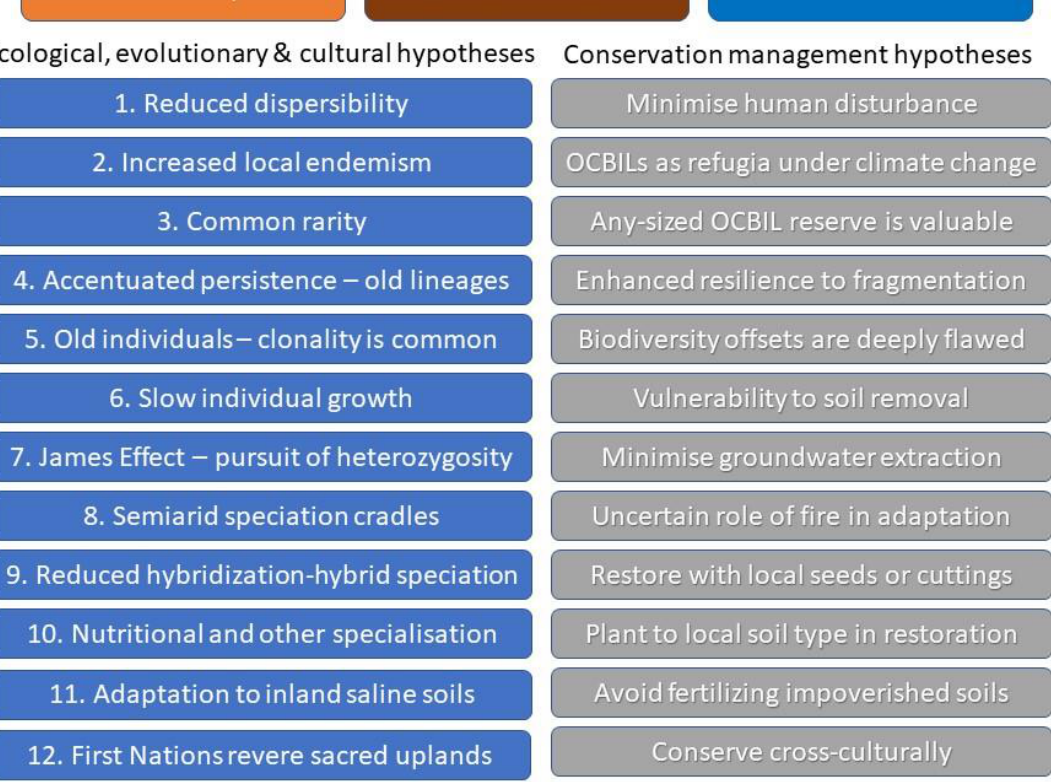
Figure 1. OCBIL theory in overview (modified from [6]), according to the foundational attributes that define OCBILs—old landscapes that are climatically buffered with reduced disturbance levels, and characterised by infertile (P-deficient) soils. There are 12 predictive ecological, evolutionary, and cultural hypotheses and 12 conservation management hypotheses that combined provide a testable foundation for OCBIL theory.